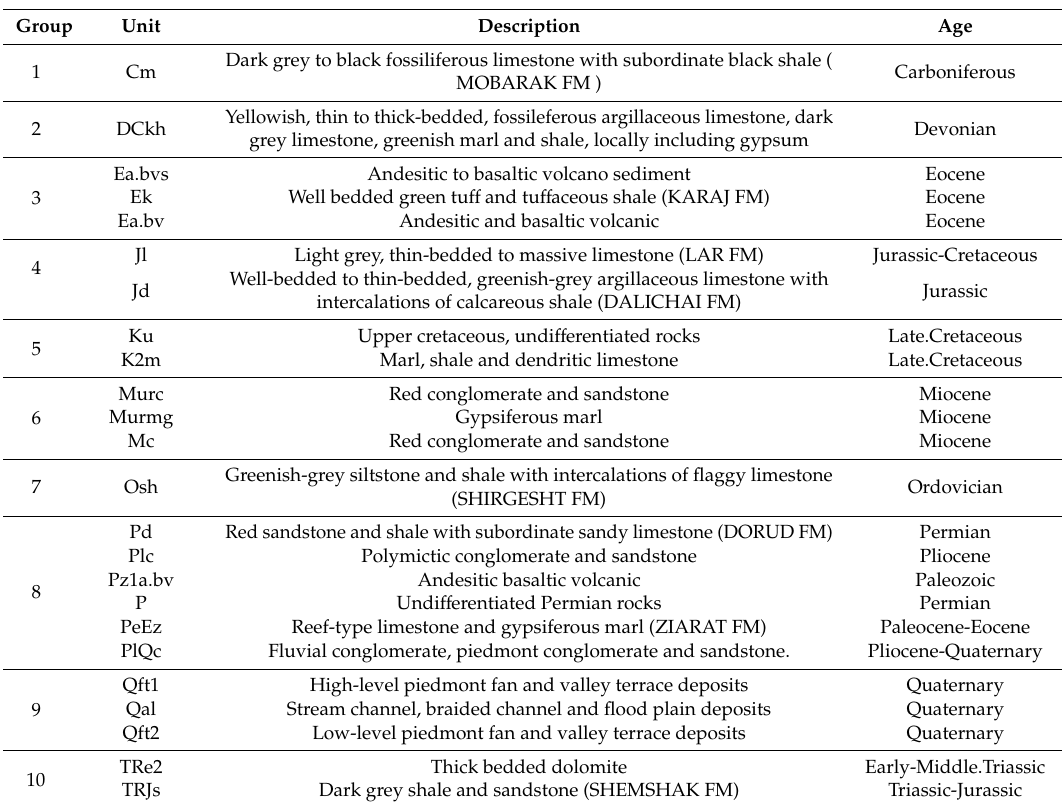
Table 1. The lithology of the study